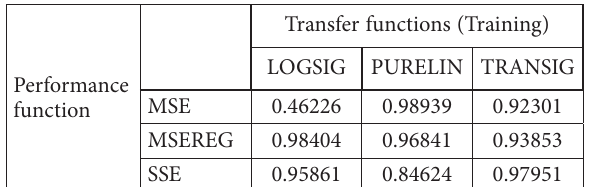
Performance function